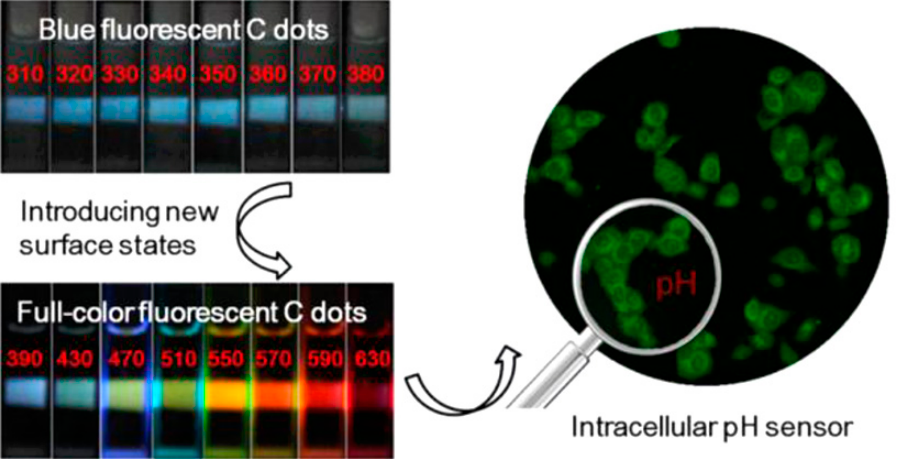
Figure 2. The integration of carbon dots with different adjusted full-color emission and pH sensors. Reprinted with permission from Ref. [34]. (Copyright, 2014 ACS).